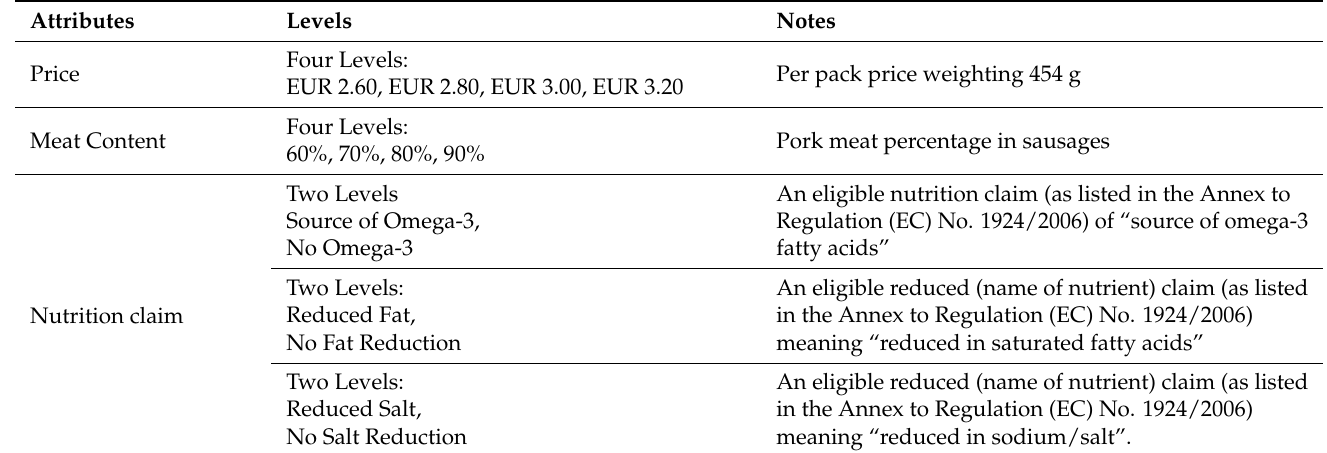
Table 1. Attributes and levels of sausages used in CBC